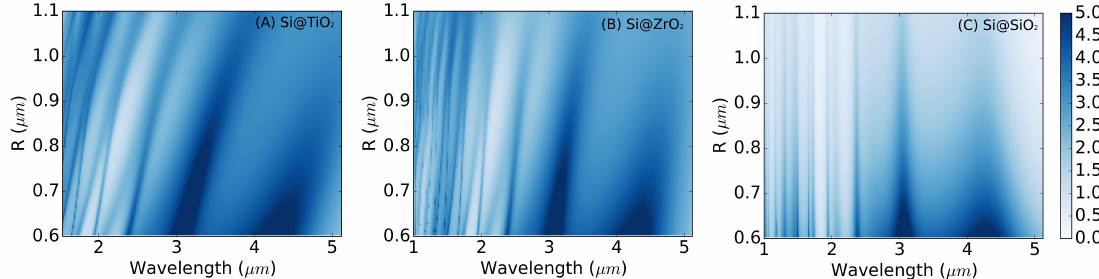
Figure 2. Q ext for core@shell semiconductor particles as a function of the total size and the incident wavelength λ : ( A ) Si@TiO 2 , ( B ) Si@ZrO 2 and ( C ) Si@SiO 2 . All particles are embedded in a medium with a refractive index of 1.5 and the core size is kept fixed at 0.6 µ